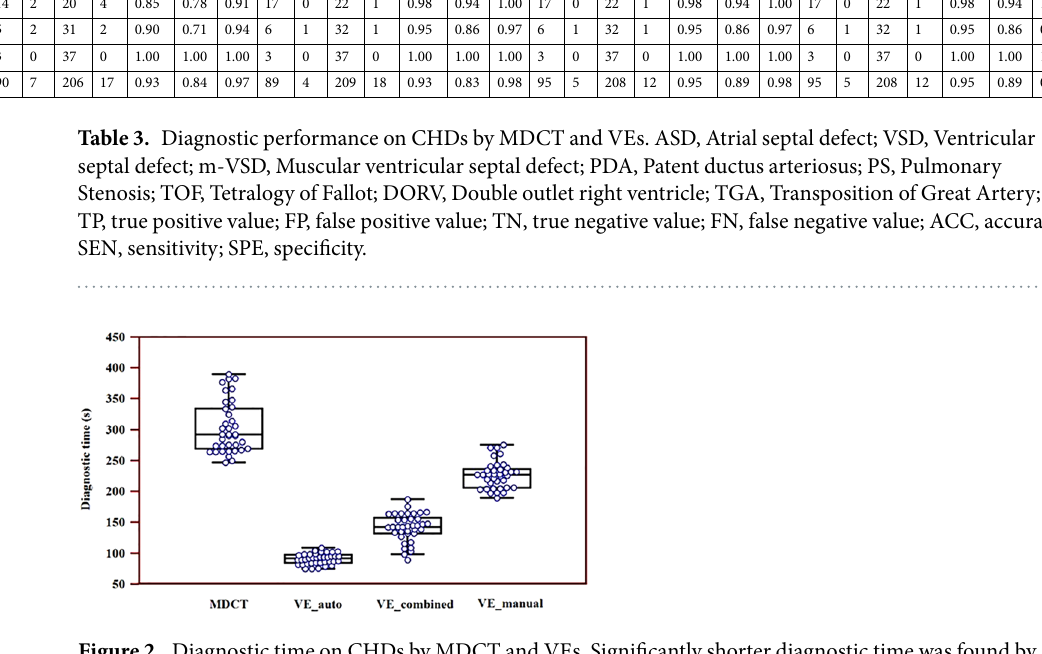
Figure 2. Diagnostic time on CHDs by MDCT and VEs. Significantly shorter diagnostic time was found by VEs as compared to MDCT (153 ± 59 vs. 303 ± 41, P < 0.05). Significantly shorter diagnostic time was observed by VE-auto as compared to VE-combined and VE-manual (91 ± 9 vs. 142 ± 22 vs. 226 ± 22s, P all < 0.05) and significantly shorter diagnostic time was observed by VE-combined as compared to VE-manual (142 ± 22 vs. 226 ± 22, P <